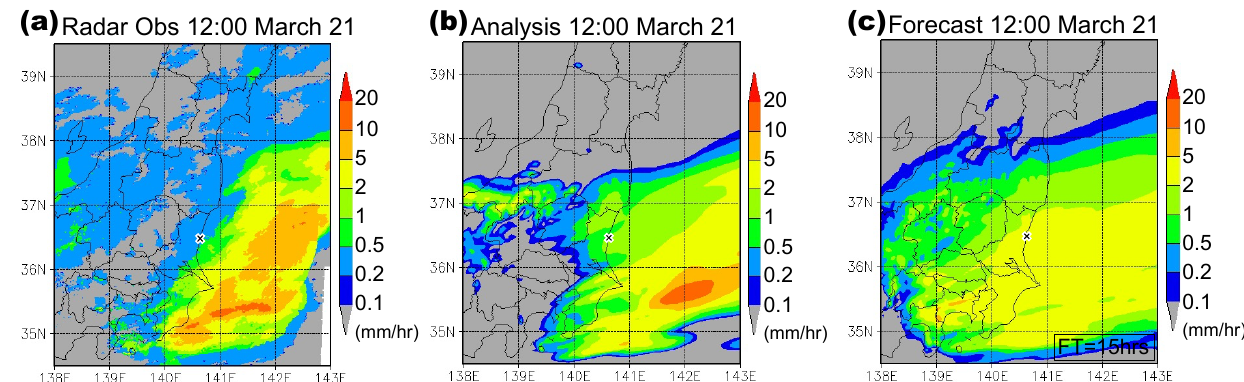
Figure 8. Precipitation (mm/hr) from 11:00 to 12:00 21 March local time derived from ( a ) the JMA operational radar/rain-gauge analyzed observations, ( b ) the deterministic analysis, ( c ) and the deterministic 15-h forecast. The cross mark illustrates the location of Tokai.